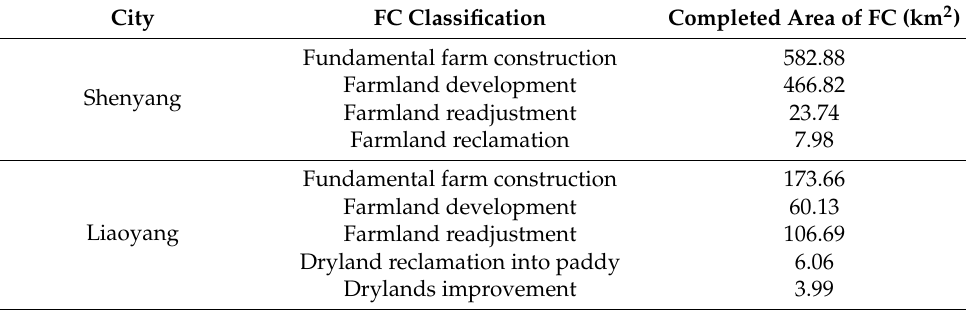
Table 1. Basic information of land consolidation